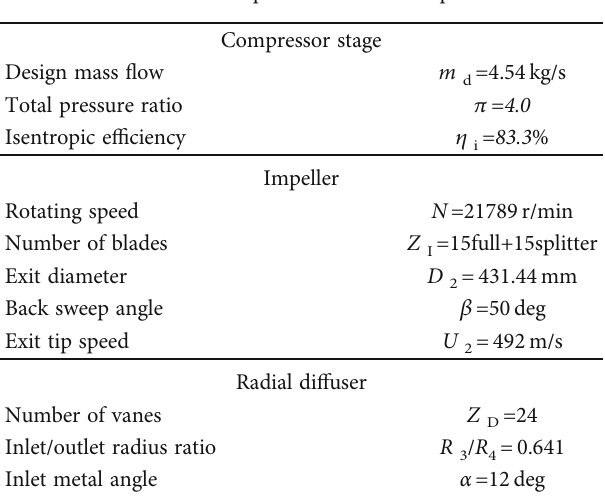
Figure 1: Centrifugal compressor fl ow path and 3d model. Table 1: Case of pressure ratio 4 compressor. Table 2: Case of pressure ratio 8